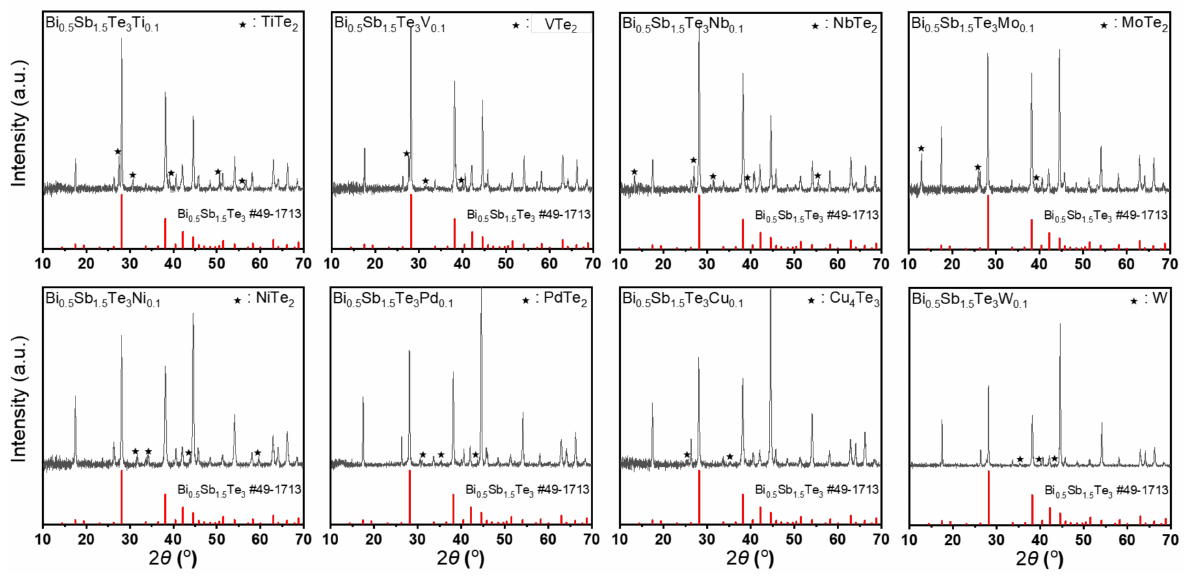
Figure 1. XRD patterns of Bi 0.5 Sb 1.5 Te 3 M 0.1 (M = Ti, V, Nb, Mo, W, Ni, Pd and Cu).